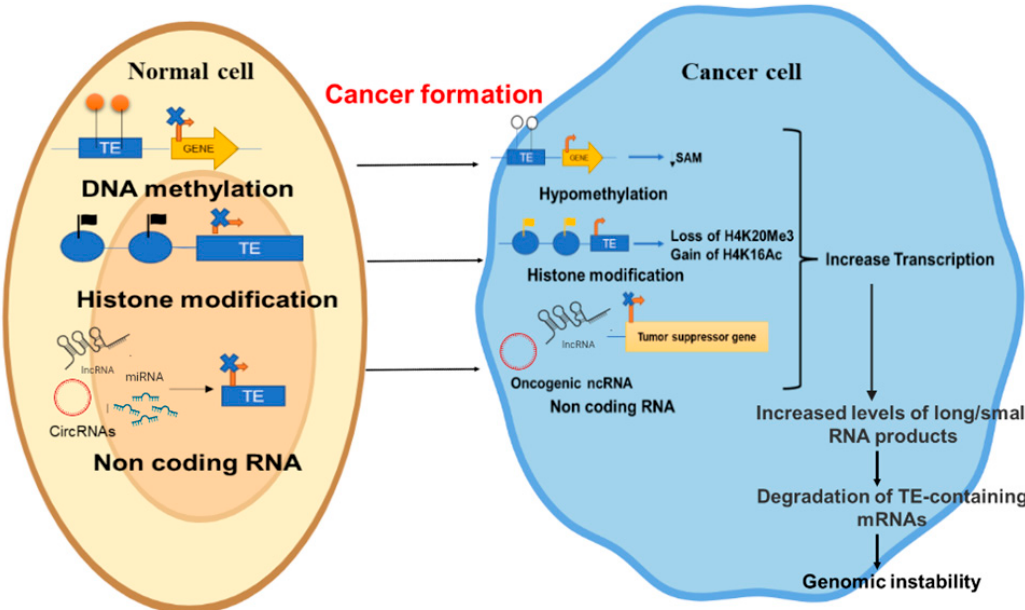
Figure 3. Regulation of TEs in the normal and cancer cell. In normal cells ( left panel ), epigenetic modifications like DNA methylation, histone modification, and non-coding RNA, silence the activity of TEs. In cancer cells ( right panel ) hypomethylation, different histone modification, and non-coding RNAs cause removal of repressive signals and unregulated expression of TEs. This leads to degradation of DNA, mutations, and genomic instability (orange arrowhead indicates the increased activity, blue circle indicates histone, orange circle indicates methyl groups, blue cross indicates silencing).